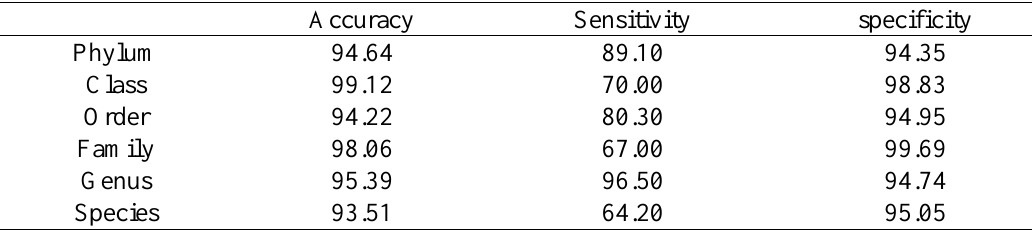
Table 4. Accuracy, Sensitivity, and specificity of clustering in